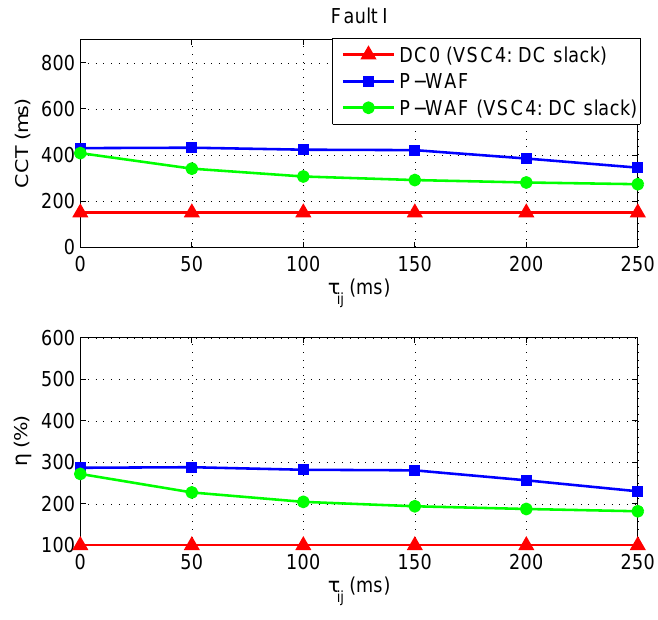
Figure 23. CCTs and η versus communication